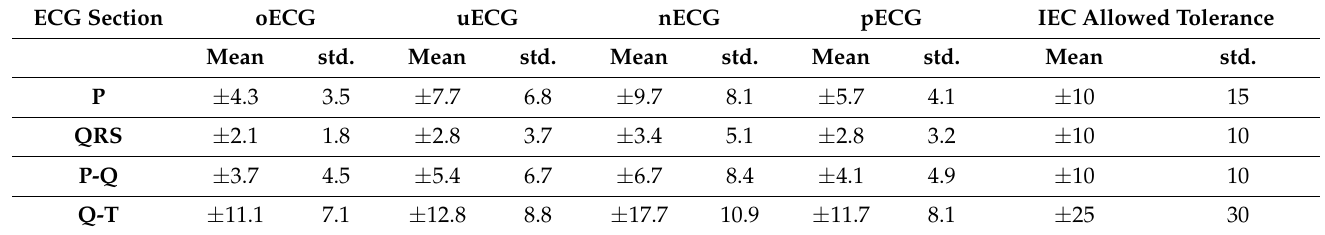
Table 7. Accuracy of waves and sections delineation in original, uniformized, non-uniform, and pseudo-non-uniform ECG [ms]. ECG Section